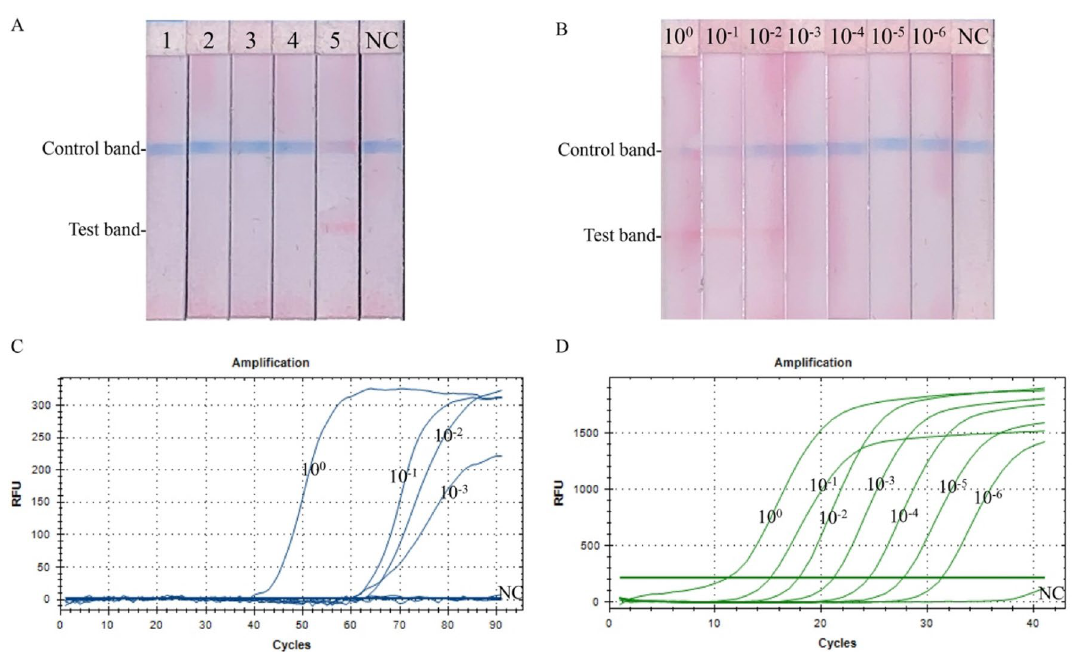
Figure 2. Evaluation of BPMV detection by the RT-CPA-LFD assay. ( A ) Specificity of the RT-CPA-LFD assay for BPMV detection. 1–5, RNA templates of leaves infested with SBMV, ToRSV, ArMV, TRSV, and BPMV, respectively. ( B – D ), Sensitivity test for BPMV detection by RT-CPA-LFD, real-time fluorescent RT-CPA, and TaqMan-MGB real-time RT-PCR. Dilutions (10 0 –10 −6 ) of total RNA of the BPMV-infected leaf sample were with the initial concentration of 50 ng/µl. NC, negative control with RNase-free distilled